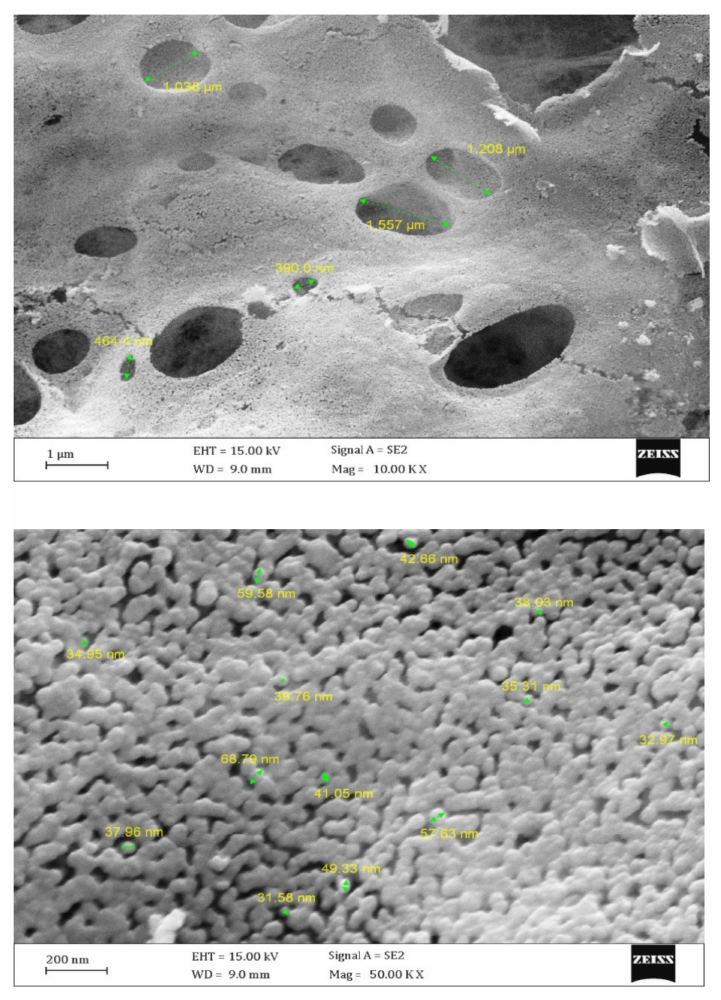
Figure 5. FESEM images of ZnO-Nd